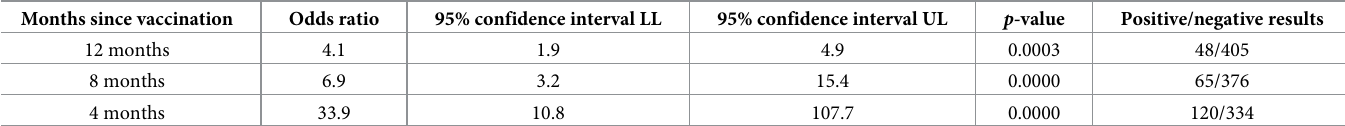
Table 4. Statistical data concerning the level of antibodies to F1 Y . pestis among all participants of the study.